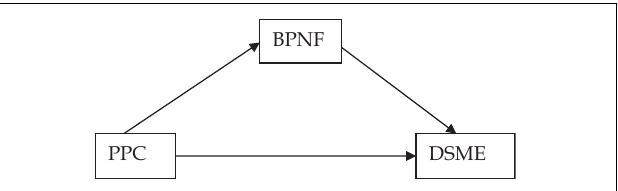
FIGURE 2 | Hypothesized relationships between PPC, BPNF, and DSME. PPC, parental psychological control; BPNF, basic psychological need frustration; DSME, dysregulation in social media